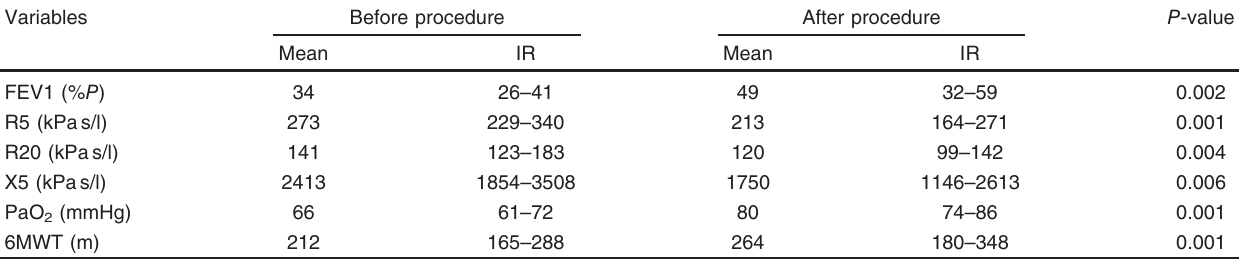
Table 3 Outcome measures before and after the biological bronchoscopic lung volume reduction Variables